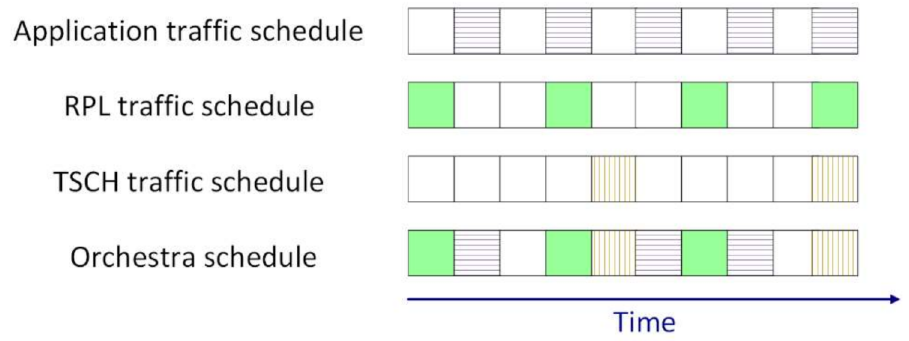
Figure 3. Example of TSCH slots grouped into repeating slotframes by